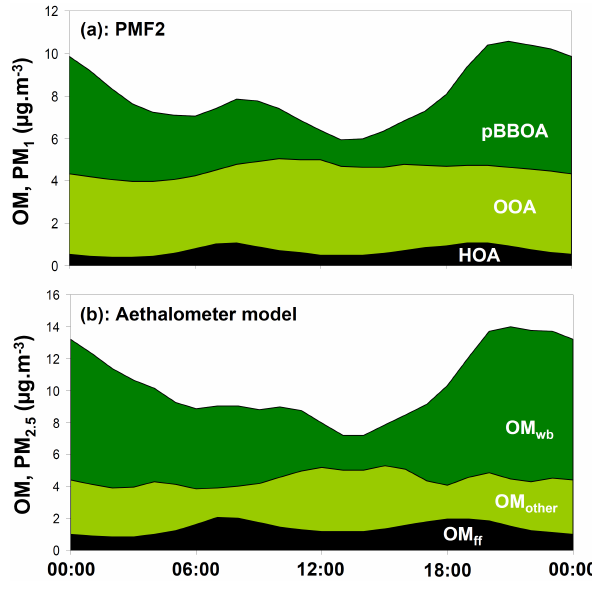
Figure 7 Fig. 7. Mean diurnal variations of each OA components obtained (a) using PMF2 as detailed in Sect. 5, and (b) using the Aethalome- ter model as detailed in Sect.